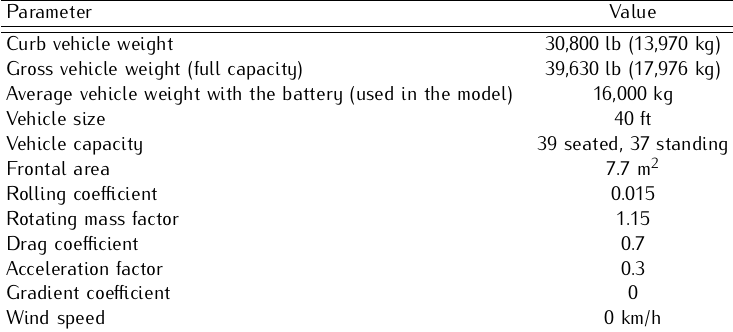
Table 3. Plug-in parallel hybrid transit bus specifications.